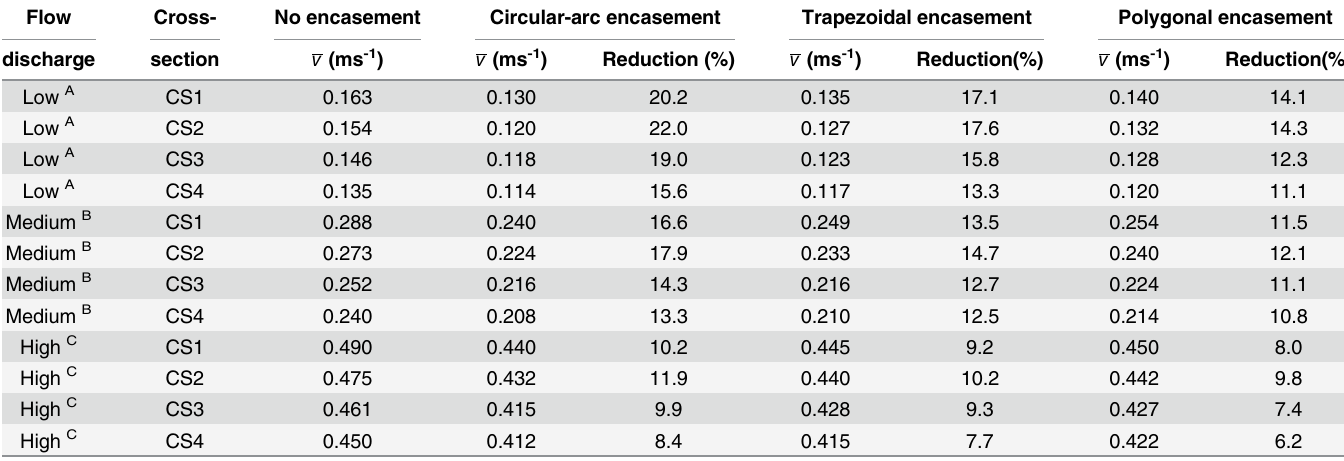
Table 2. Averaged flow velocities v of CS1-CS4 before and after the installation of concrete pipe encasements.